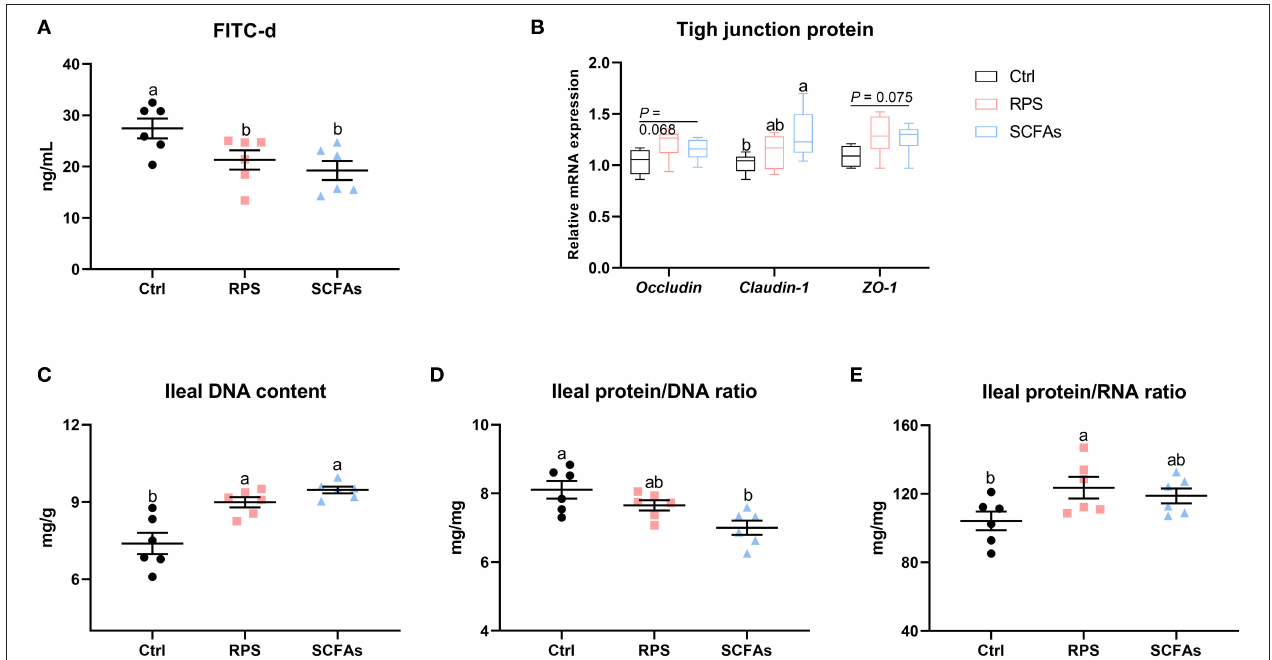
FIGURE 5 | Dietary RPS and drinking SCFAs enhance intestinal barrier and biochemical indices of mucosal growth. Intestinal integrity was assessed by (A) direct measurement using fluorescein isothiocyanate dextran (FITC-d) and (B) the mRNA level of tight junction proteins including occluding , caudin-1 , and zona occludens-1 ( ZO-1 ). Biochemical indices of mucosal growth including (C) DNA content, (D) protein/RNA ratio, and (E) protein/RNA ratio of the ileal mucosal homogenate were assessed. Data are expressed as mean and standard deviation. a,b Mean values with different letters are significantly different by one-way analysis of variance followed by Tukey’s post-hoc test ( p <